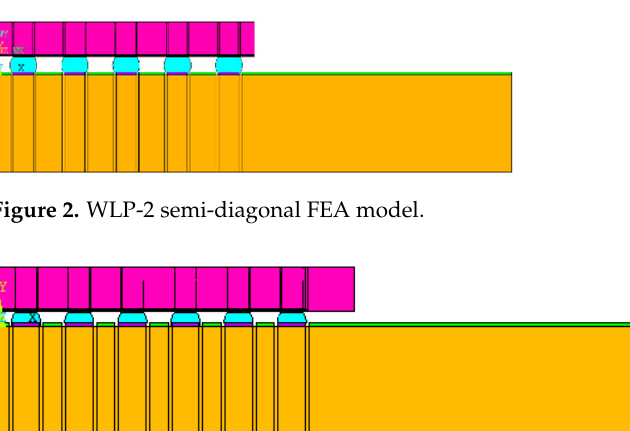
Figure 1. WLP-1 semi-diagonal FEA model.